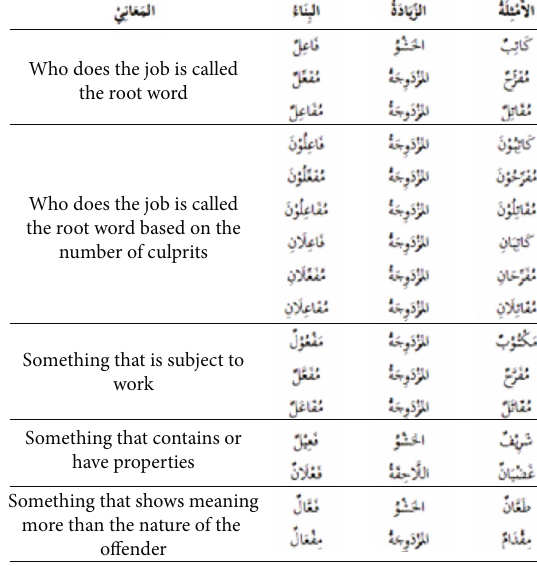
Figure 1: Word formation with Az-zaaidah in